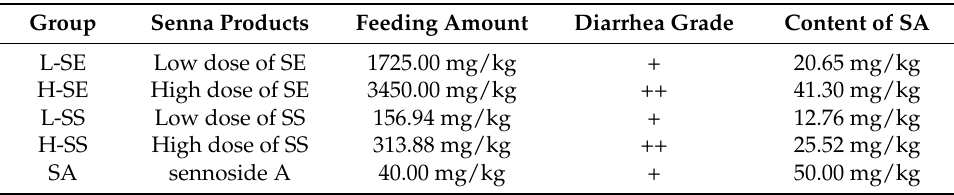
Table 1. Diarrhea-rats generation by feeding the senna products.